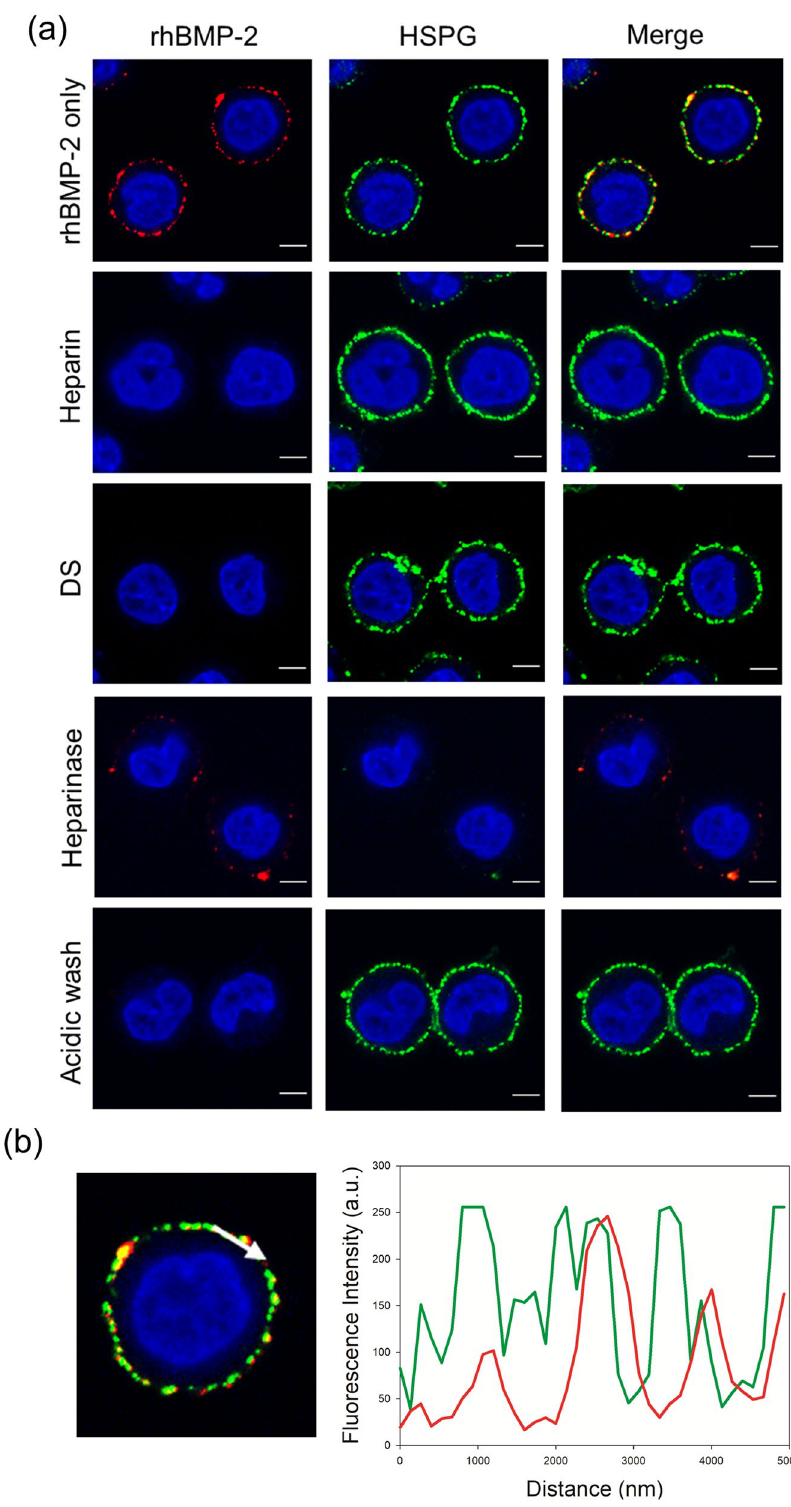
Figure 3. Binding of rhBMP-2 to cell surface HSPGs in DG44 cells. ( a ) Confocal microscopy to examine rhBMP-2 binding to cell surface HSPGs in the absence or presence of heparin and DS. Cells were incubated for 1 h at 4 °C with purified rhBMP-2 (10 μg/mL) alone or in the presence of heparin (0.1 g/L) or DS (0.5 g/L). Cells pre-treated with heparinase I/III (indicated as heparinase) and cells washed with acidic buffer (indicated as acid buffer) were also incubated for 1 h at 4 °C with purified rhBMP-2 alone. rhBMP-2 was stained red, while HSPGs were stained green. Nuclear counterstaining (blue) was carried out using DAPI. The merge image highlights co-localization (yellow) of rhBMP-2 and HSPGs. Scale bar, 5 μm. ( b ) The fluorescence intensity profile of HSPGs (green) and rhBMP-2 (red) across the arrow shown in a confocal image in Fig.